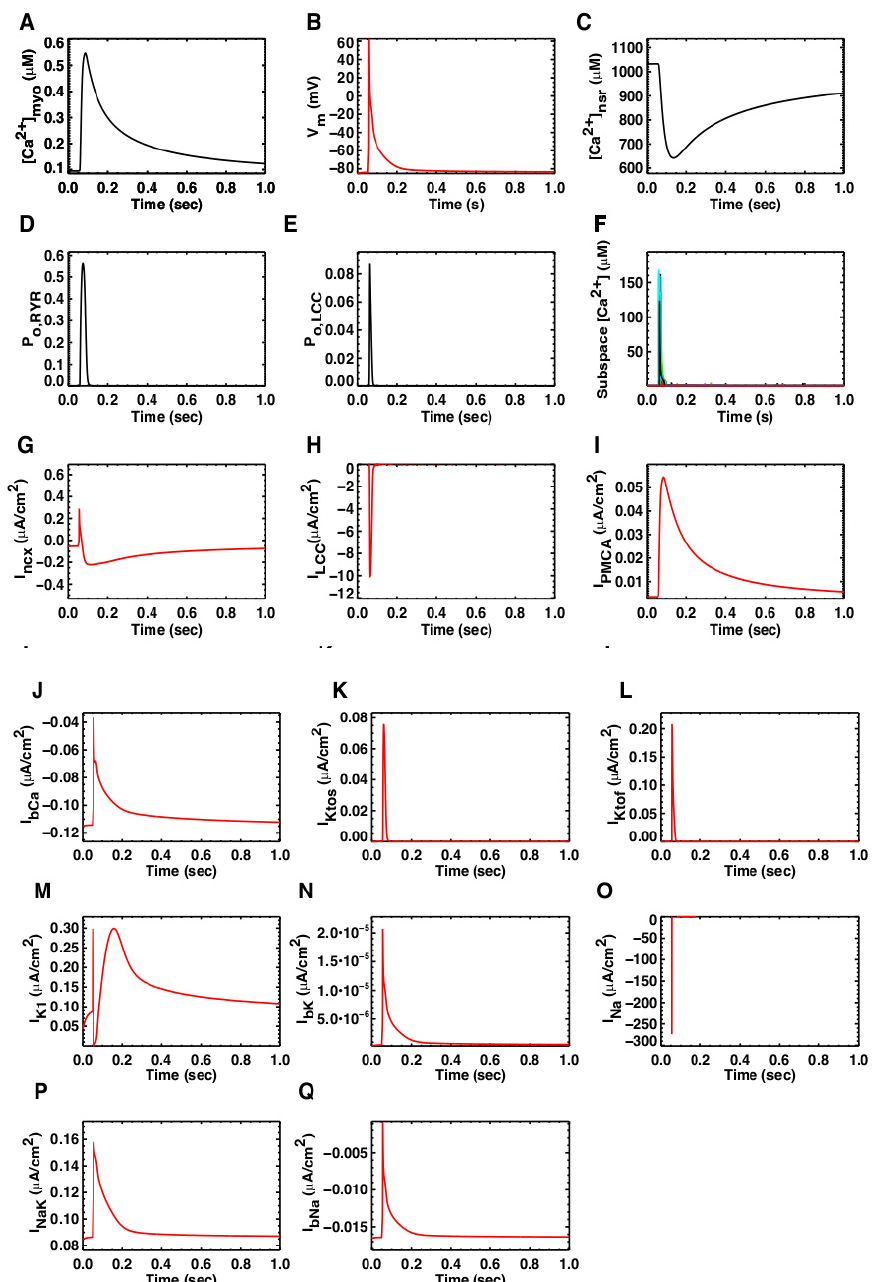
Figure A2. A single action potential at 1 Hz pacing. To emulate the excitation-contraction of the cell, a stimulus current Istim = − 6.5189 µA/cm2 was given during 5.0 ms second [40] . ( A ) [Ca 2+ ] myo , ( B )